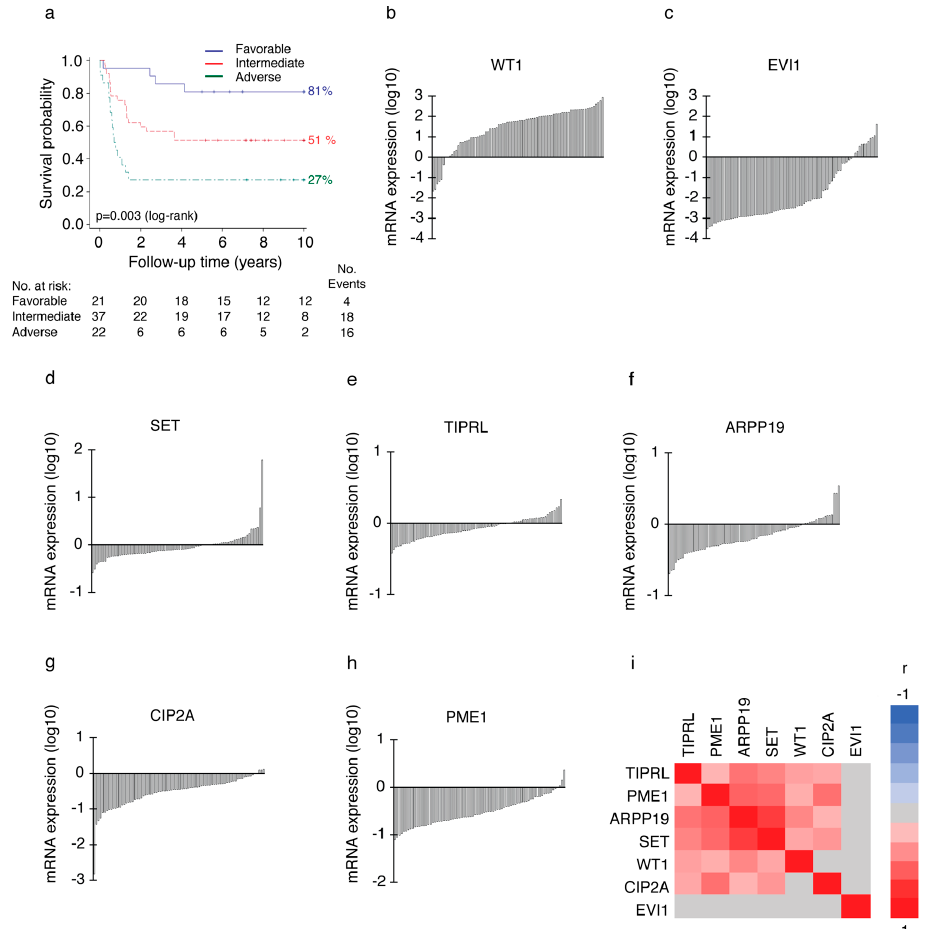
Figure 1. Expression profiles of PP2A inhibitors in acute myeloid leukemia (AML) patient samples. a ) The higher risk group is significantly associated with poor survival of AML patients in patient cohort1. p = 0.003 by log-rank test. Favorable n = 21, intermediate n = 37, adverse n = 22. b ) to h ) Waterfall blots of analysed genes from the sample panel normalized to GAPDH & b-actin expression and a pooled ( n = 56) normal bone marrow sample. On the y-axis, log10 transformed RQ mRNA expression values derived from two technical replicates in two independent experiments. One bar represents one patient. b ) WT1 mRNA expression was highly overexpressed (91%) in diagnosis phase AML patients’ bone marrow compared to normal bone marrow. c ) EVI1 overexpression was 13%, d ) SET overexpression was 30%, e ) TIPRL overexpression was 30%, f ) ARPP19 overexpression was 21%, g ) CIP2A overexpression was 4% and h ) PME1 overexpression was 4% in the sample panel. i) Hierarchical clustering of Pearson’s pairwise correlations for the mRNA expression of PP2A inhibitors in patient cohort1. Three potentially oncogenic PP2A inhibitors, PME1, ARPP19 and SET, form a cluster with correlated expression patterns. Red represents positive and blue negative correlation. Grey indicates non-significant correlation ( p -value > 0.05).